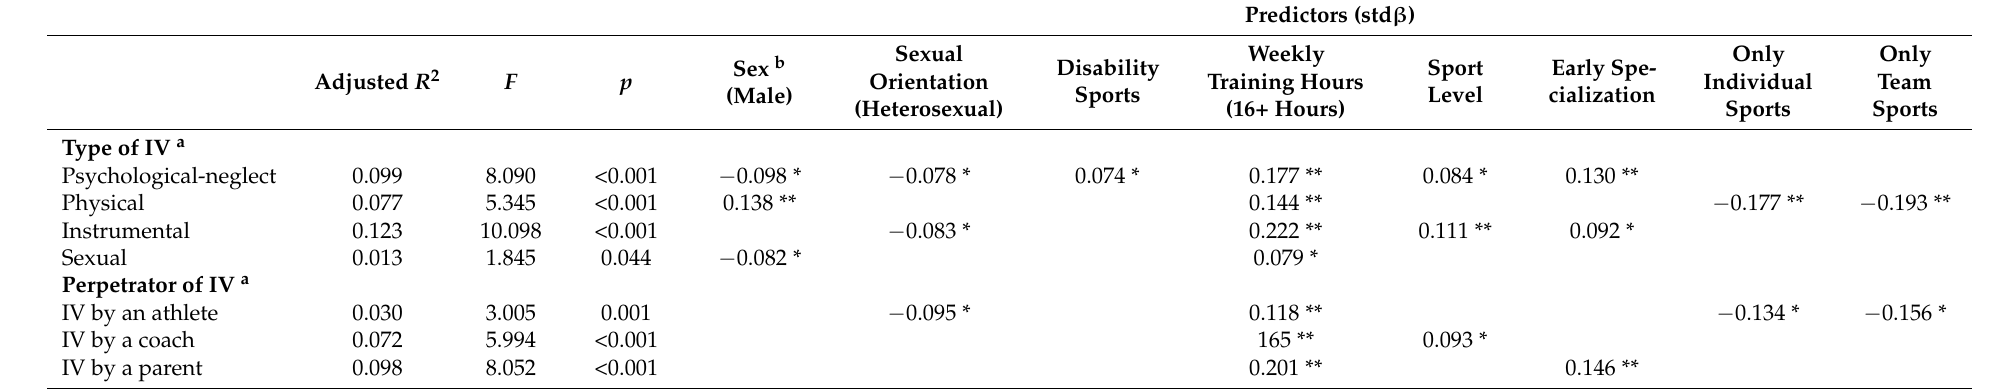
Table 2. Regression for type of IV and IV per